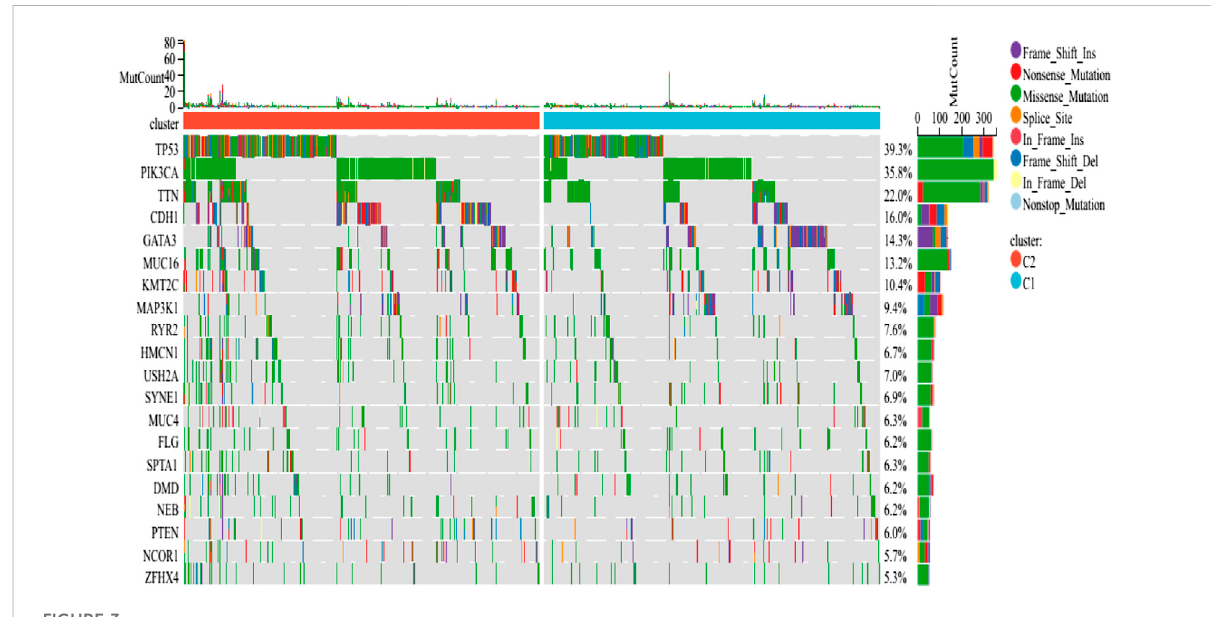
FIGURE 3 Comparing the somatic mutations occurring in the various ICD